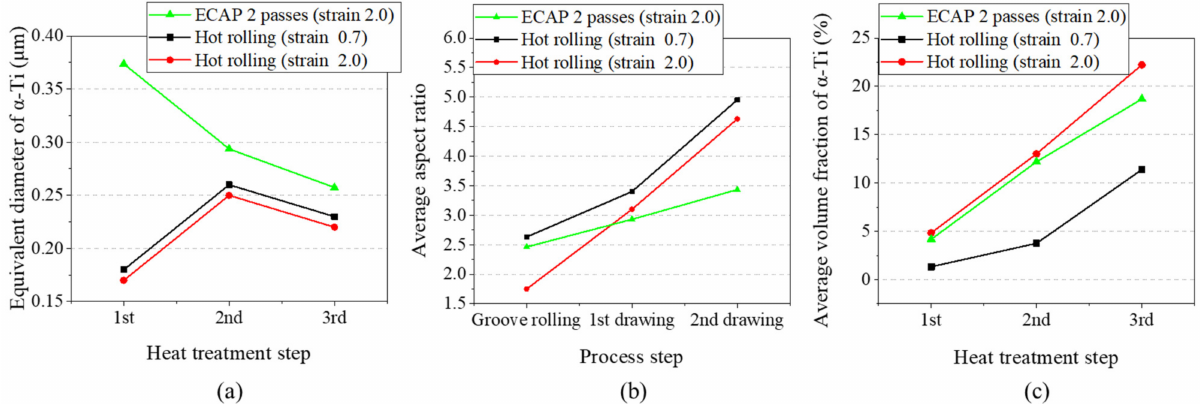
Figure 6. Graphs depicting ( a ) equivalent diameter of the α -Ti phase after each heat treatment, ( b ) average aspect ratio of the α -Ti phase after each cold work and ( c ) average volume fraction of the α -Ti phase after each heat treatment. Results of the ECAPed specimen with a strain of 2.0 and the hot rolled specimen with a strain of 0.7 are reused from references [16] and [17],